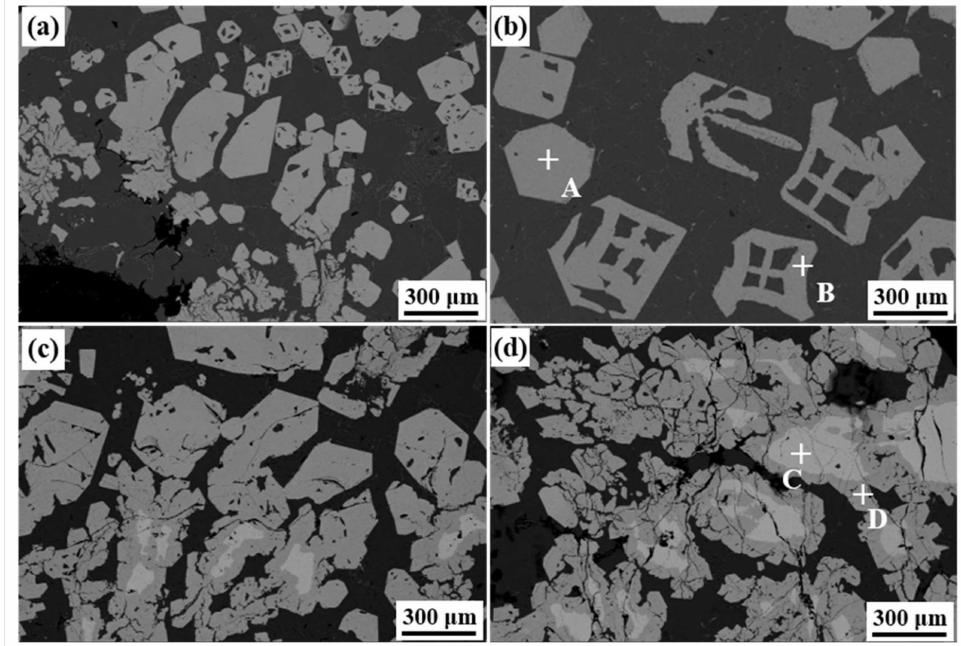
Figure 4. Microscopic morphology of slag with different Fe content.( a ) 0.8%; ( b ) 1.2%; ( c ) 1.8%; ( d ) 2.4%.